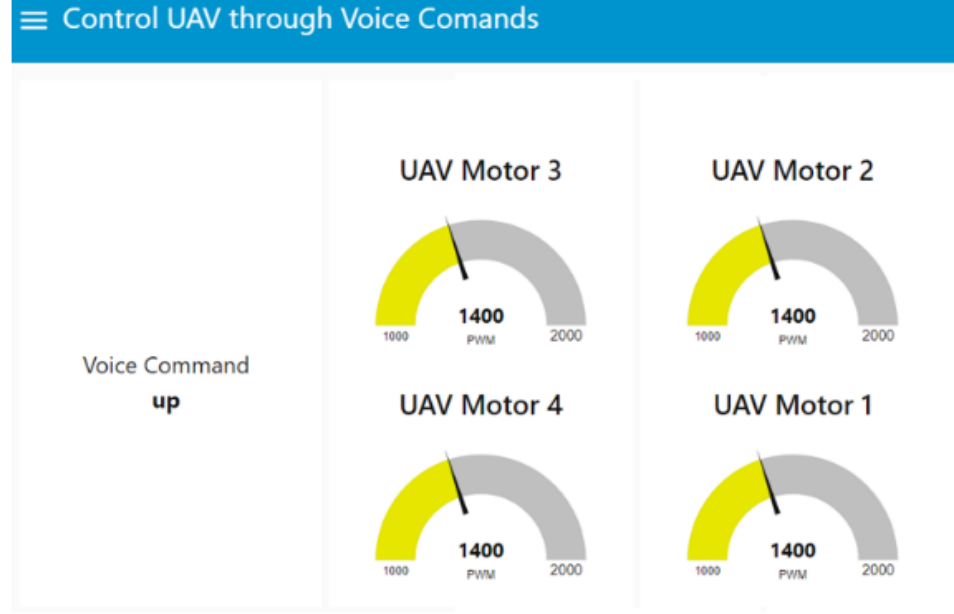
Figure 12. Graphical interface for AMLSR system.